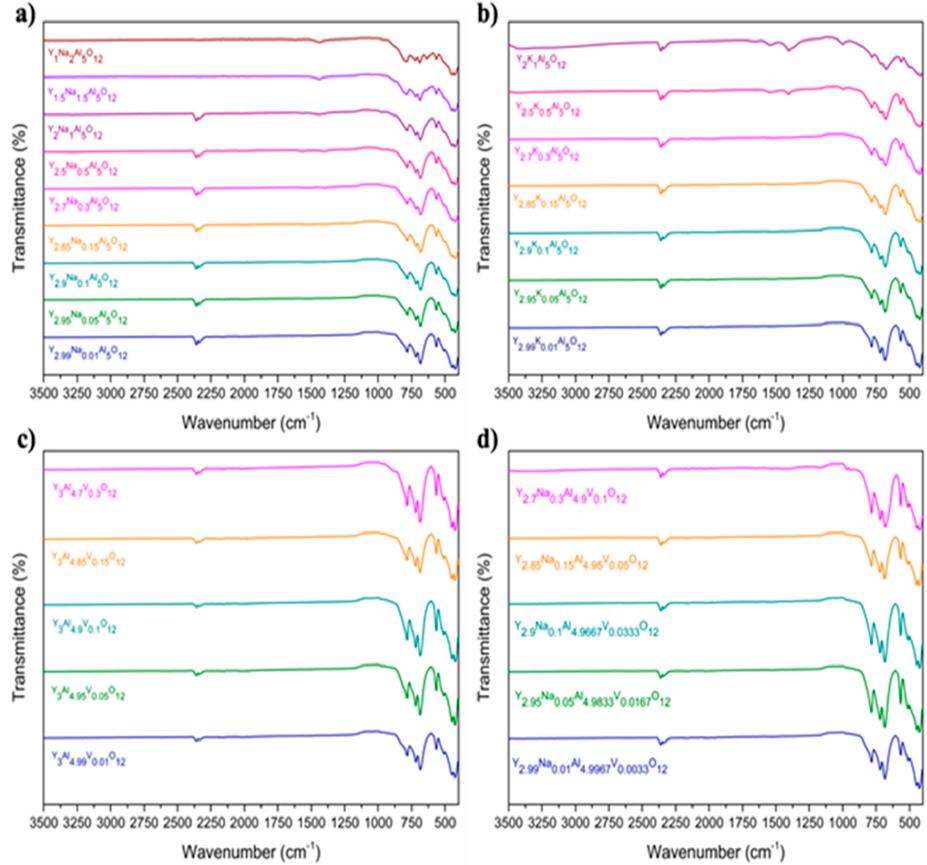
Figure 2. FTIR spectra of the Y 3 − x Na x Al 5 O 12 ( a ), Y 3 − x K x Al 5 O 12 ( b ), Y 3 Al 5 − y V y O 12 ( c ), and Y 3 − x Na x Al 5 − y V y O 12 ( d ) samples synthesized at 1000 °C for 2 h. The surface morphology of Y 3 − x Na x Al 5 O 12 , Y 3 − x K x Al 5 O 12 , Y 3 Al 5 − y V y O 12 , and Y 3 − x Na x Al 5-